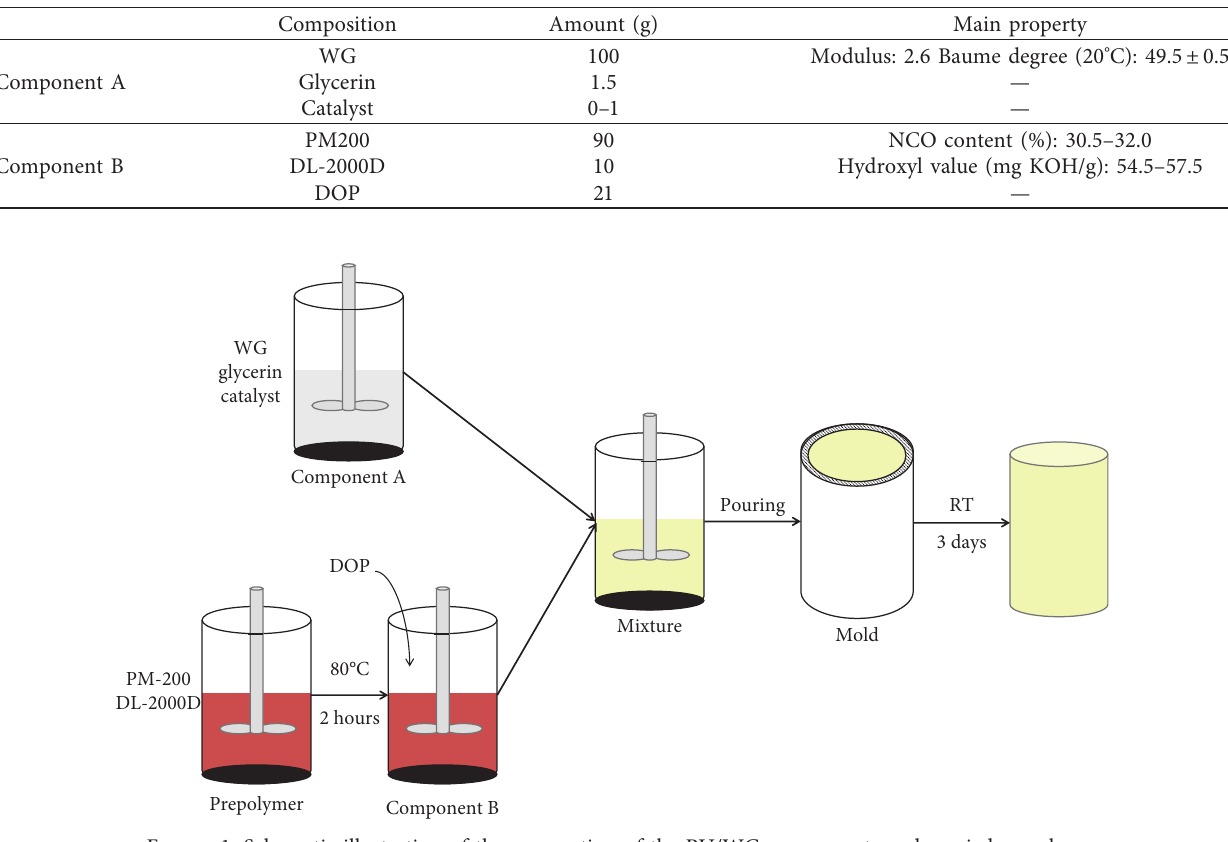
Figure 1: Schematic illustration of the preparation of the PU/WG components and curried samples.